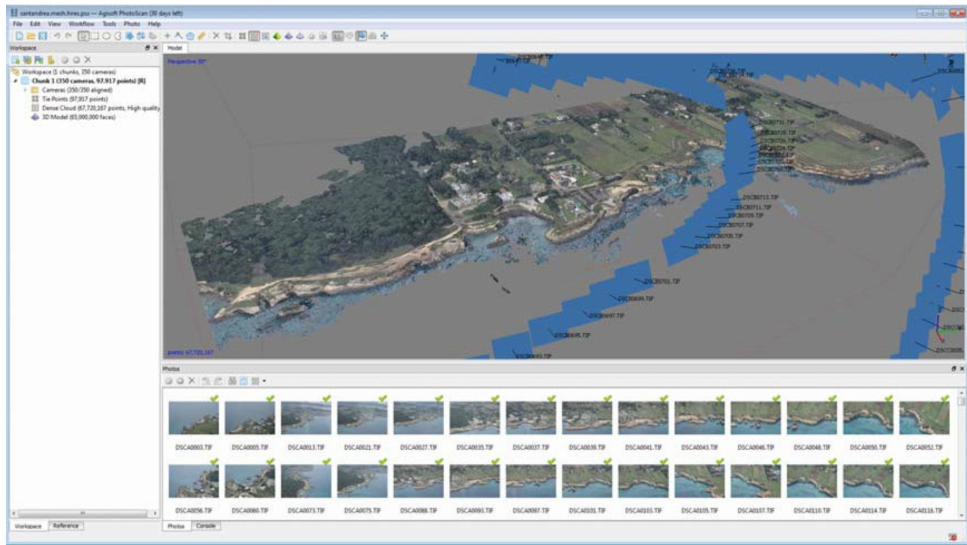
The point-cloud model was generated and georeferenced in Photoscan (Figure 8) magnitude. The dense clouds were subsequently exported in LAS format.